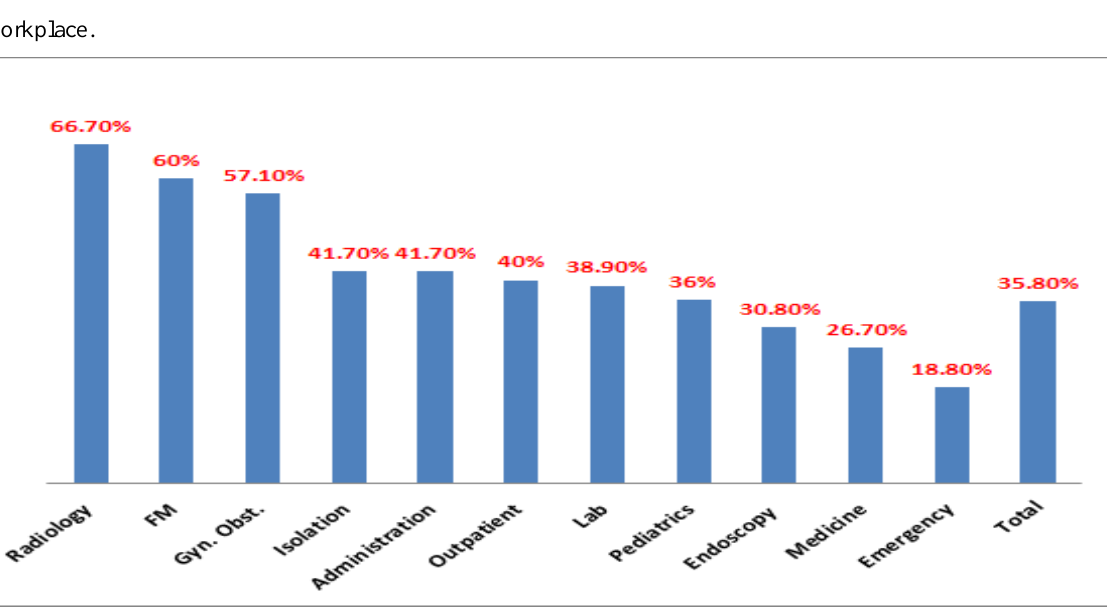
Figure 2. The odds ratio (and 95% confidence interval) of SARS CoV2 antibody positivity in relation to characteristics of the studied HCWs. Only cough was a significant risk factor ( p =0.036) while smoking was a protective factor ( p